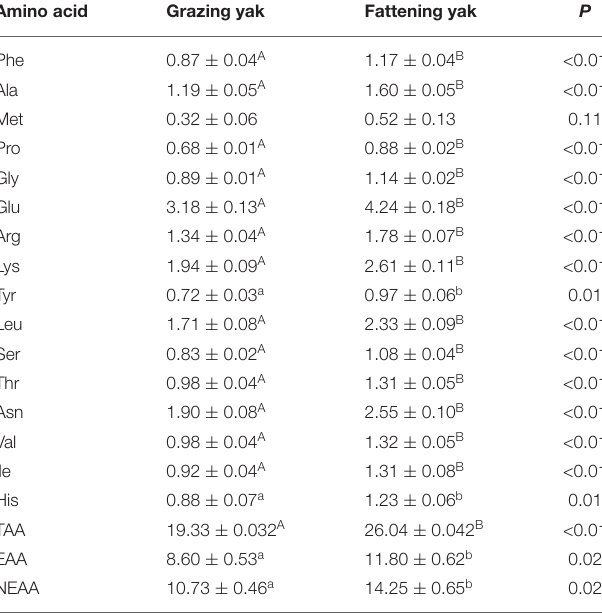
TABLE 4 | Effects of the intensive fattening with TMR on the fatty acid composition in longissimus dorsi muscle of yaks (mean ± SD, g/100g). Fat acid Grazing yak Fattening yak